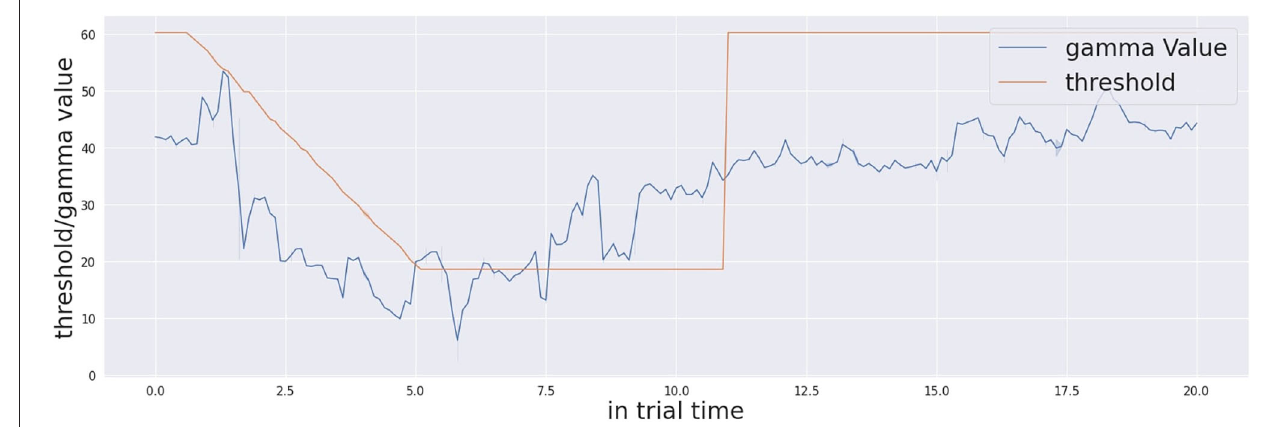
FIGURE 5 | Gamma measure ( ˆW) and the threshold profiles in one of the trials across the whole trial time (20 s). The crossing occurs around 5